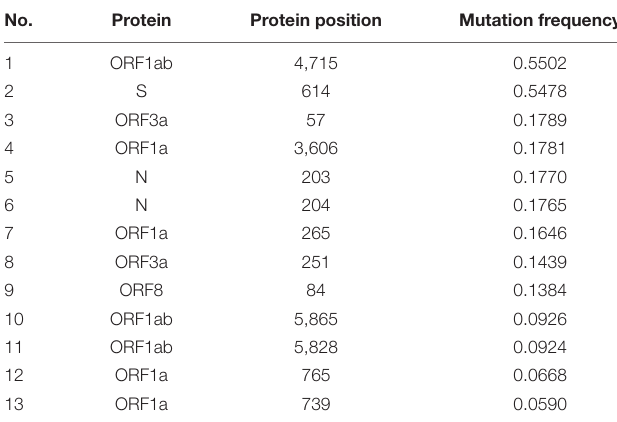
TABLE 5 | The most frequently mutated positions within the SARS-CoV- 2 proteome.